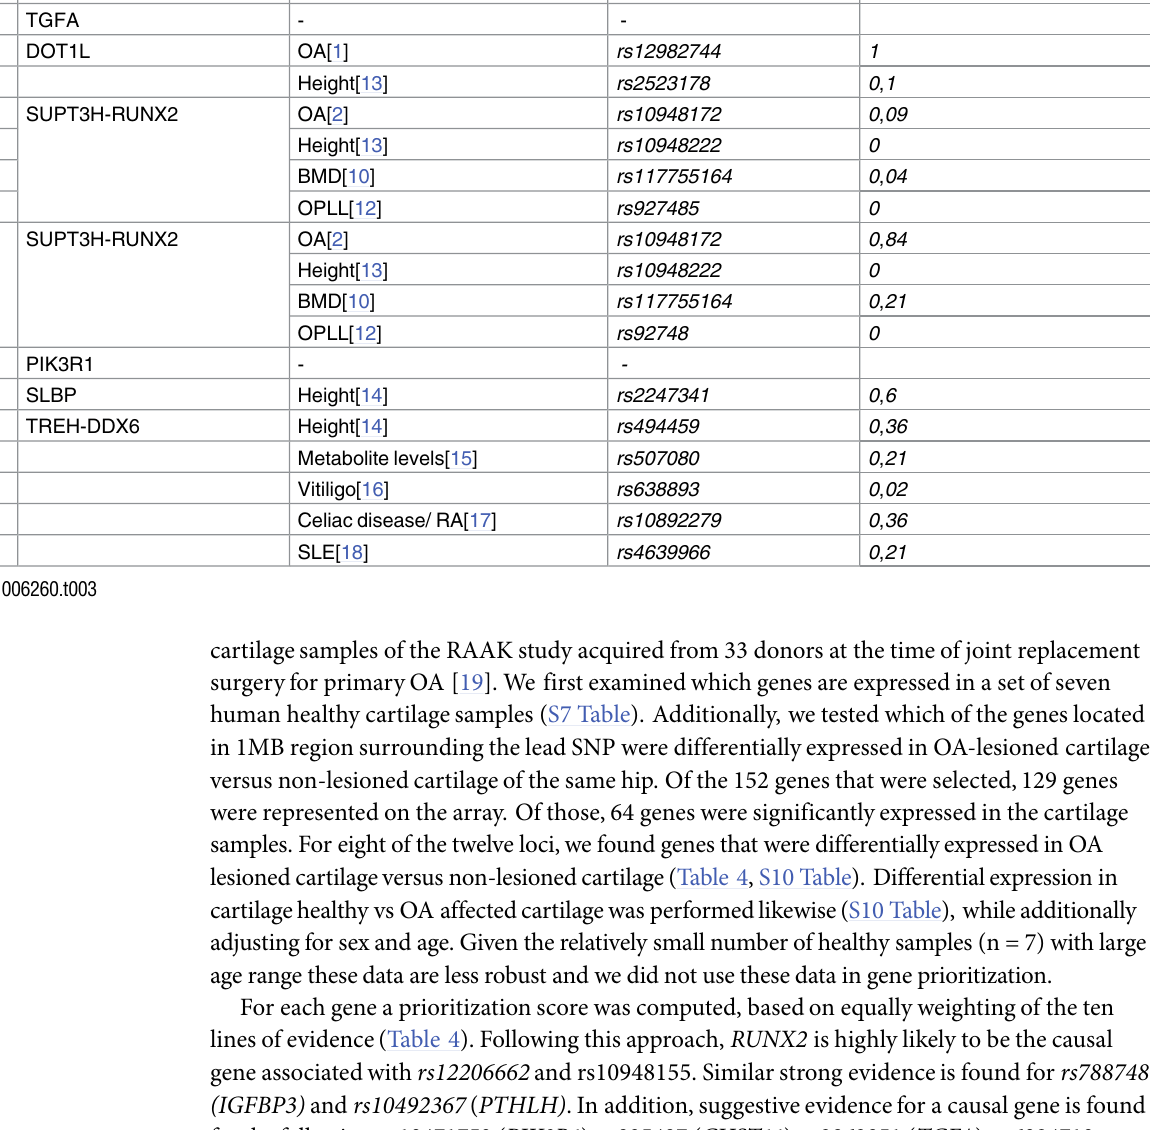
Table 3. Association of mJSW loci with previously reported phenotypes SNP